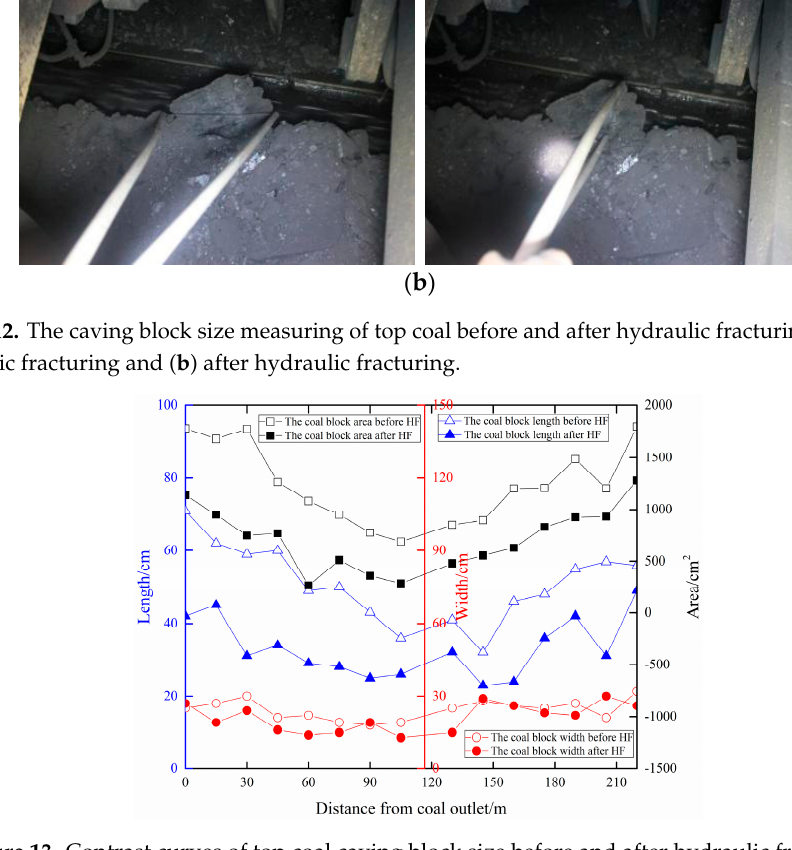
Figure 13. Contrast curves of top coal caving block size before and after hydraulic fracturing.